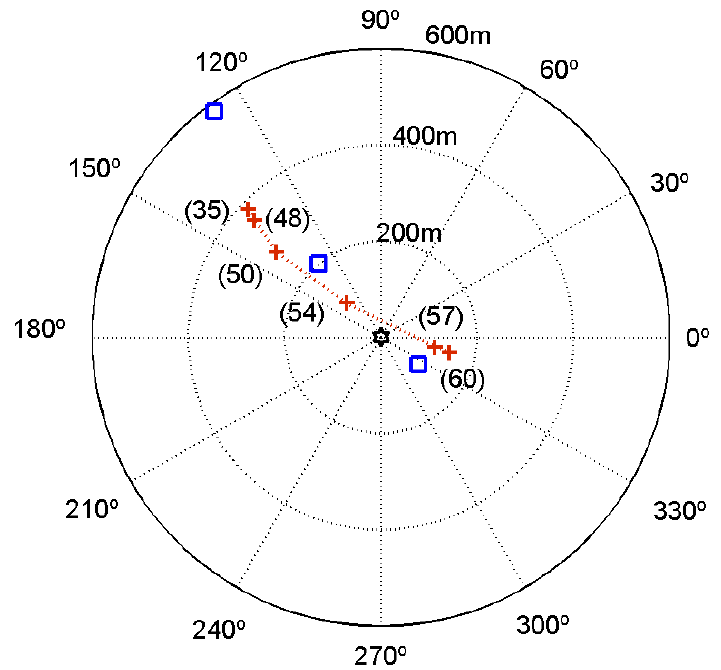
Figure 10. Estimated source location (cross marks) relative to the R/V Kilo Moana (located at the origin) of the Makai’05 field calibration event. The square marks indicate GPS fixes obtained with a handheld GPS on board the source rubber boat. The values in brackets represent the time (in min) of Tables 3 and